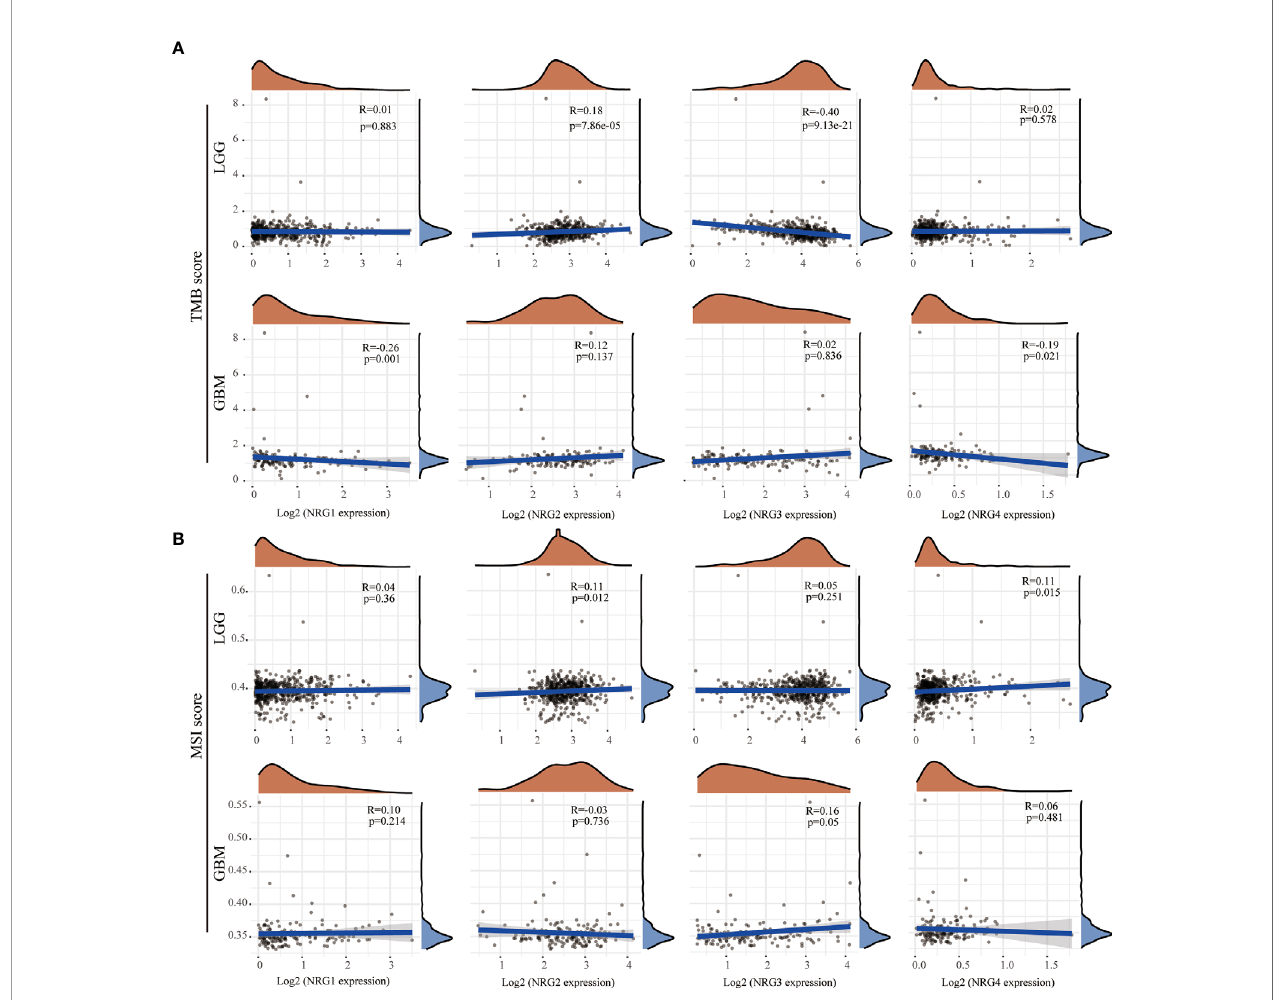
FIGURE 6 | Correlations between NRGs expression and TMB/MSI in LGG and GBM. Correlation analysis of NRG1-4 expression and TMB (A) /MSI (B) in LGG and GBM. The horizontal axis represents the expression distribution of NRG1-4, and the ordinate represents the expression distribution of TMB/MSI score. The density curve on the right represents the distribution trend of TMB/MSI score; the upper density curve represents the distribution trend of NRG1-4. Spearman ’ s correlation analysis was used to describe the correlation. P < 0.05 was considered statistically signi fi